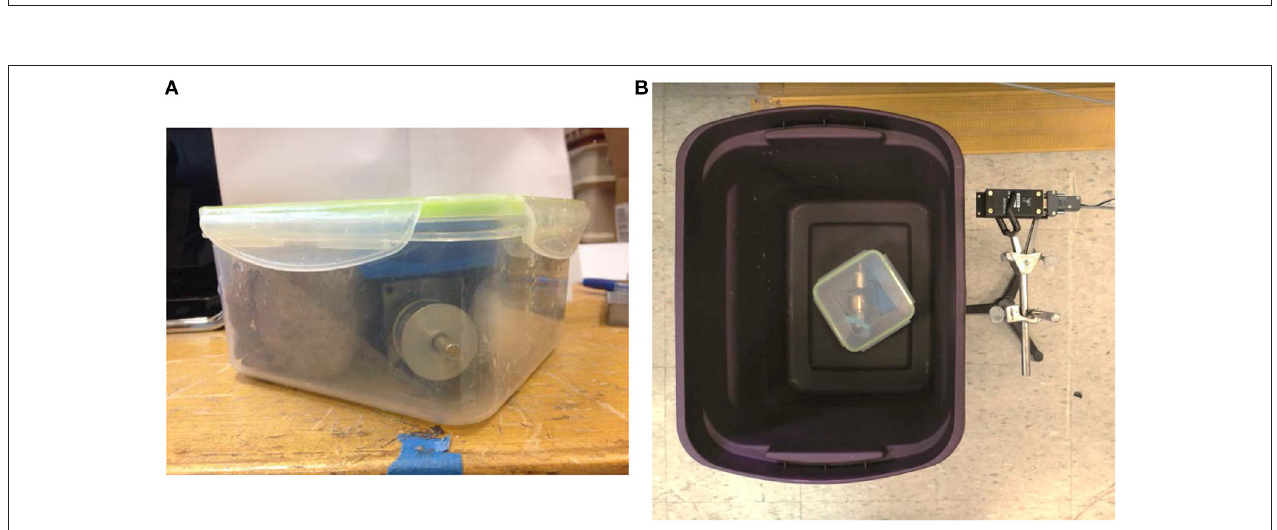
FIGURE 5 | (A) servo motor with diametric magnet and power supply in waterproof housing, and (B) waterproof housing in plastic storage bin and HMR2300 magnetometer on stand.